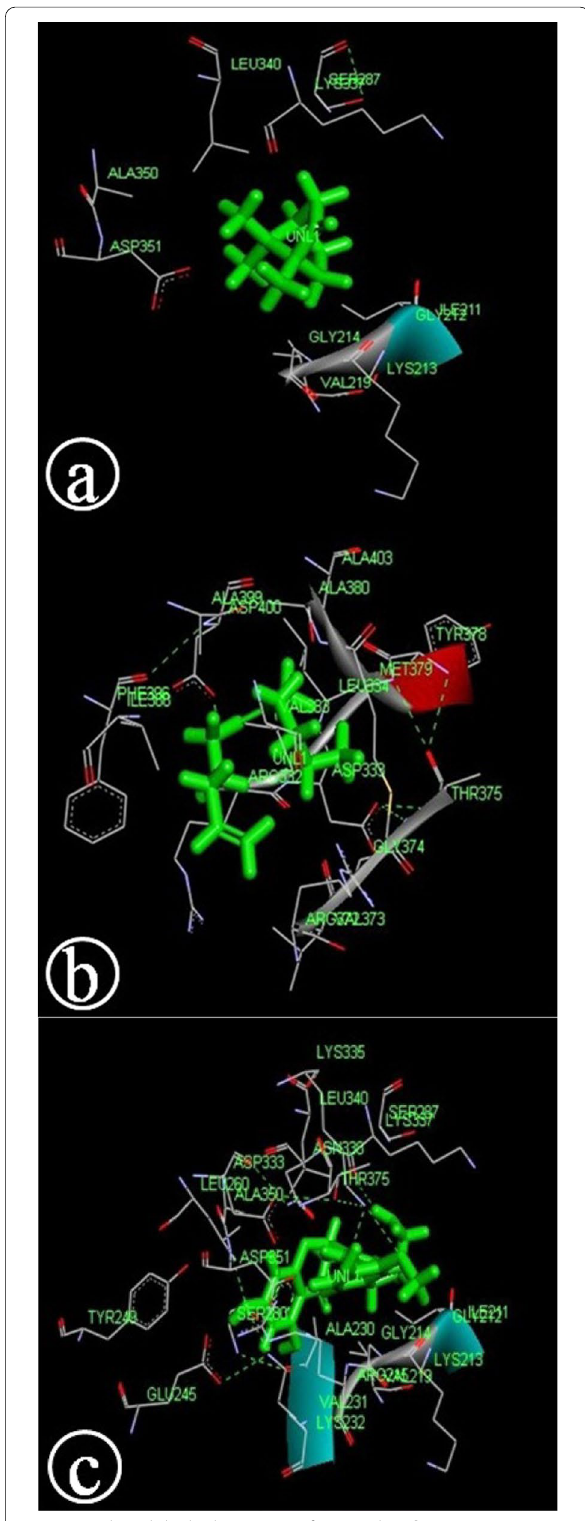
Fig. 7 Predicted docked structure of a camphor; b 2-butyl-2,7-octadien-1-ol; c silymarin for TGF-β1 (PDB ID: 1VJY)